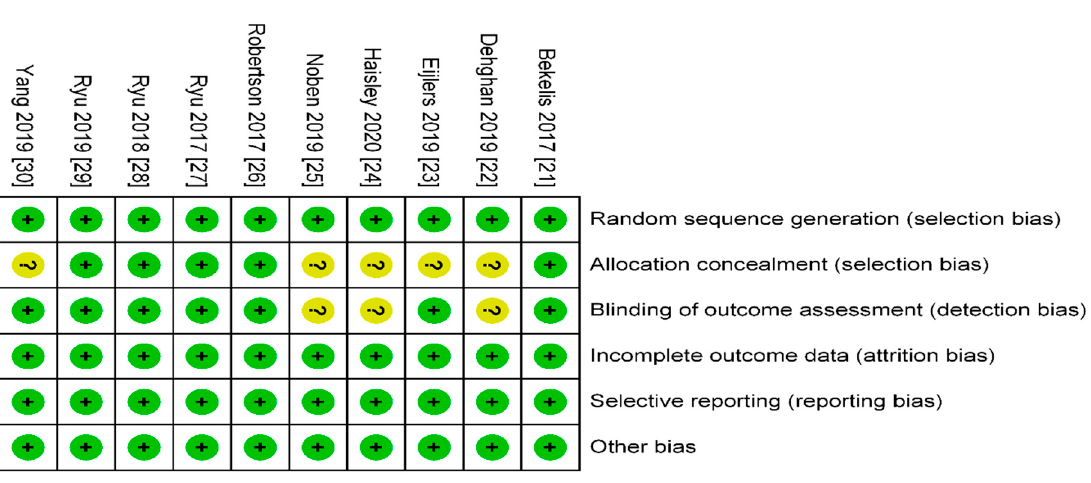
Figure 5. Risk of bias graph. The authors’ judgement about each risk of bias item for each included study. Abbreviations: + = low risk of bias, ? = unclear risk of bias.